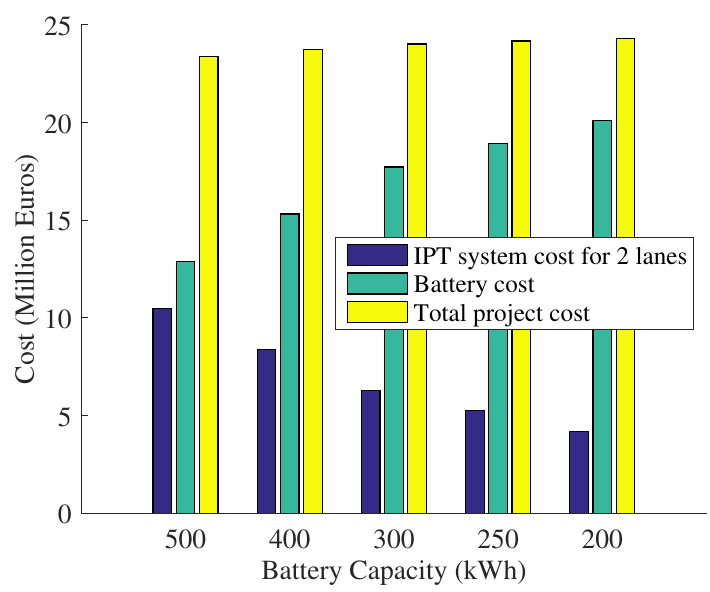
Figure 14. Battery size dependency of the incurred infrastructural costs.